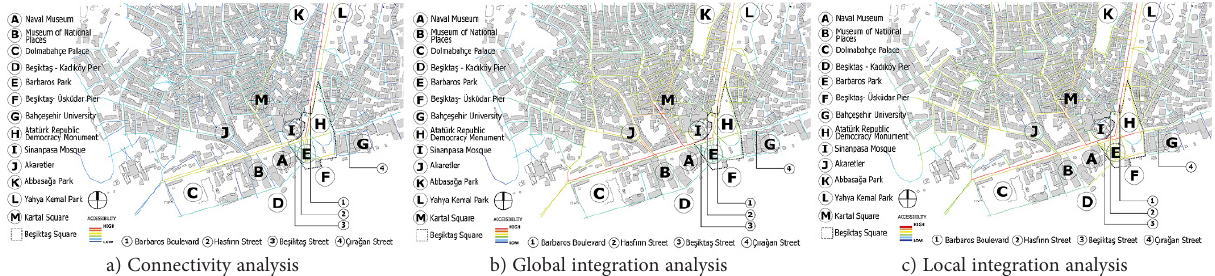
Figure 3. Connectivity, global and local integration analysis of Beşiktaş Square